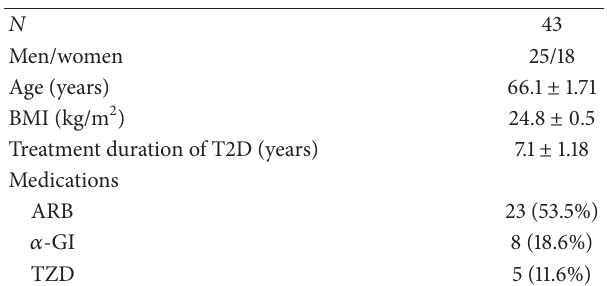
Table 1: Patient profiles.